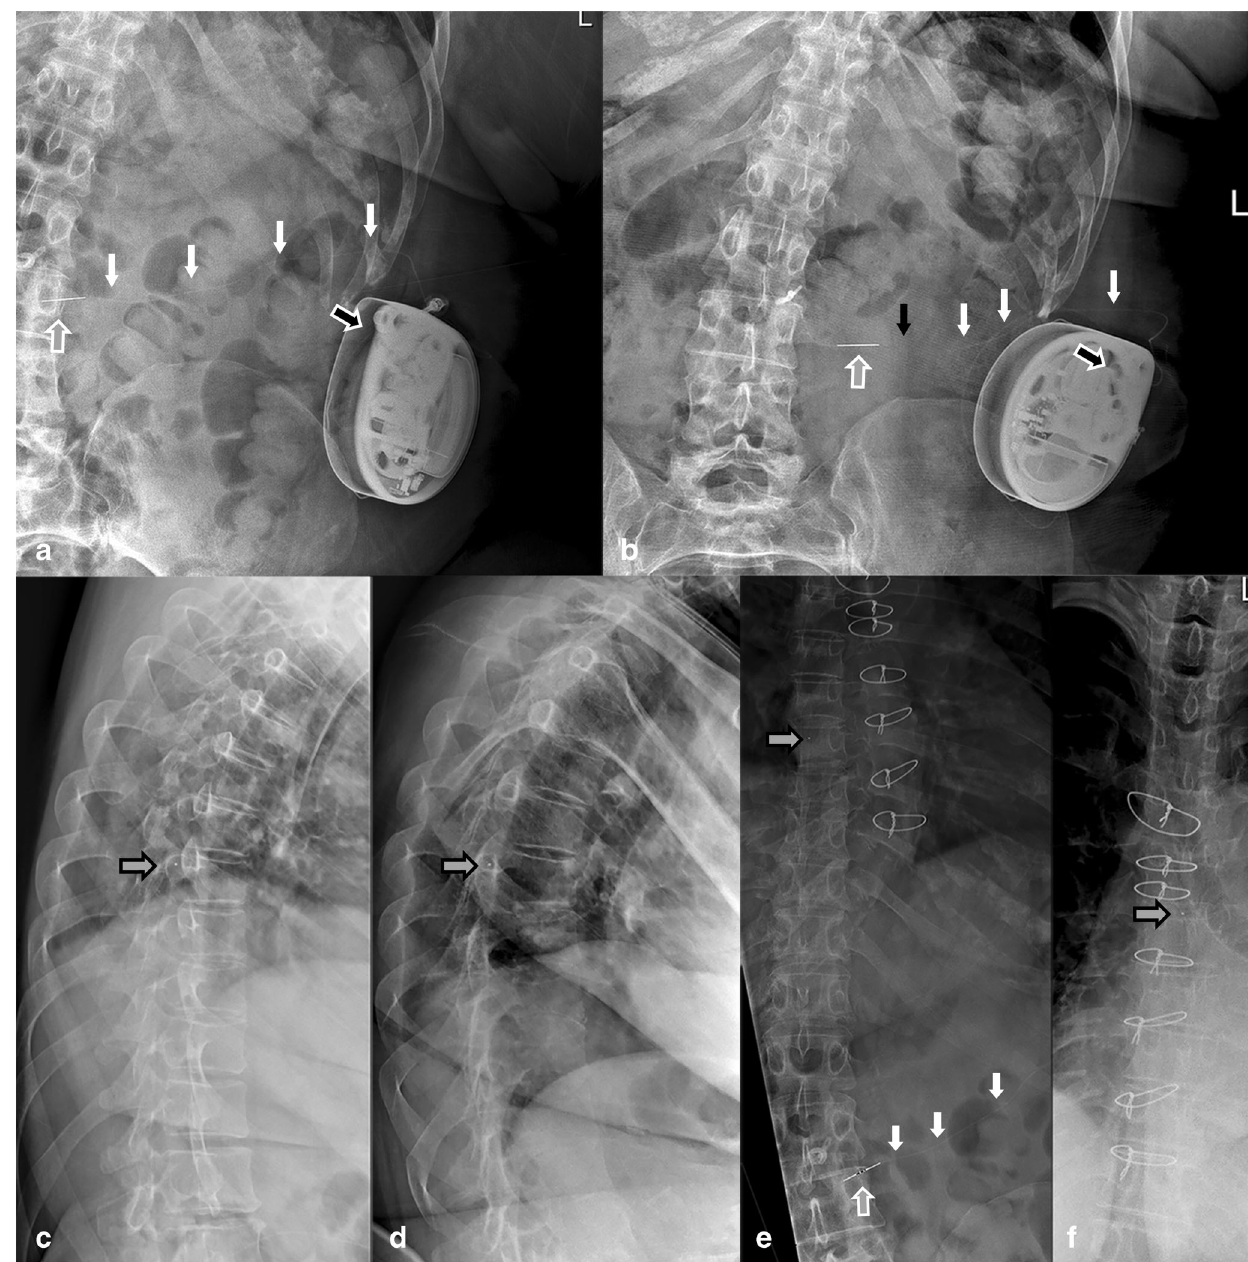
Fig. 6 Reel syndrome with signs of withdrawal syndrome in a 45-year- old extremely obese woman with spasticity in multiple sclerosis. Baseline plain radiography ( a, c, e ) with follow-up images after 4 weeks ( b, d, f ). The apex of the pump is turned from the 11 o ’ clock ( a ) to the 2 o ’ clock ( b ) position( black-whitearrow ). The Ascendaneedleconnector ismoved